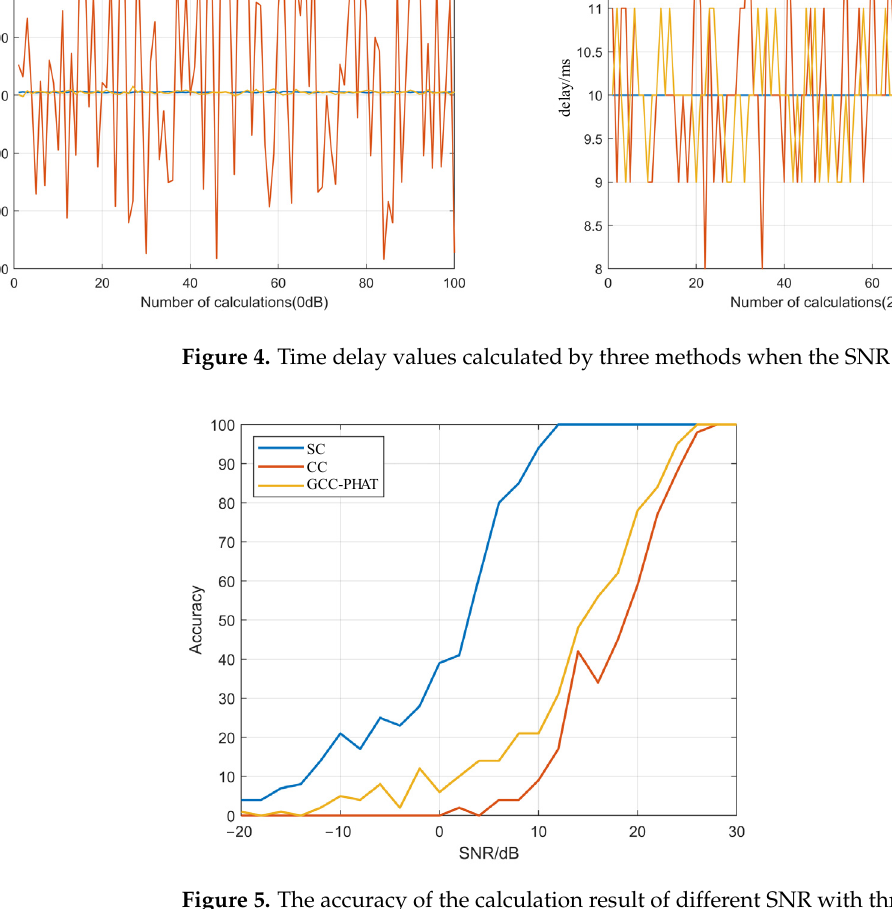
Figure 5. The accuracy of the calculation result of different SNR with three methods.